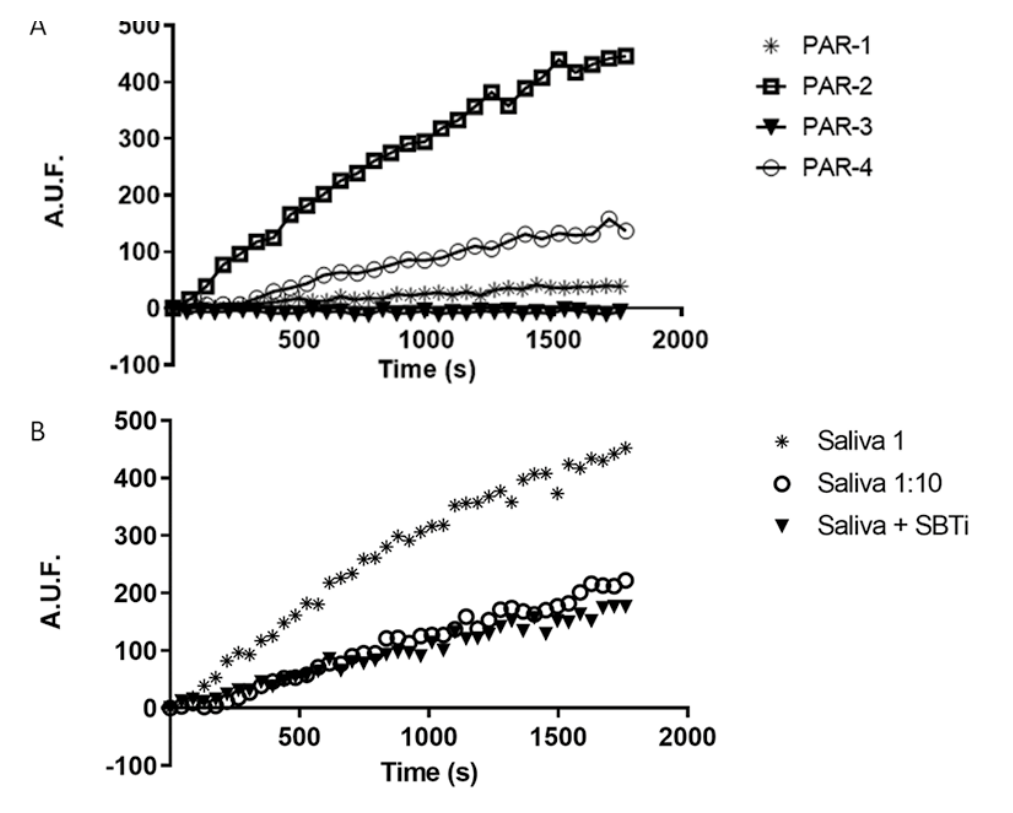
Figure 1. Time course of PAR peptides hydrolysis by T. infestans saliva. (A) Progress curves of hydrolysis of Abz-PAR-EDDnp (Abz-protease-activated receptor EDDnp) 1, 2, 3 and 4 (50 µM) by 76.8 µg/mL total protein from T. infestans saliva. Asterisk: activity of saliva on PAR1 peptide; rectangle: activity of saliva on PAR2 peptide; inverted triangle: activity of saliva on PAR3 peptide; circle: activity of saliva on PAR4 peptide. (B) Hydrolysis of PAR-2 peptide (50 µM) at different concentrations of total protein from T. infestans saliva (saliva 1 = 76.8 µg/mL; saliva 1:10 = 7.68 µg/mL) and saliva 1 in the presence of SBTI (8 µM). Asterisk: activity of concentrated saliva on PAR2 peptide; open circle: activity of diluted saliva (1:10) on PAR2 peptide; inverted triangle: activity of saliva on PAR2 peptide in the presence of